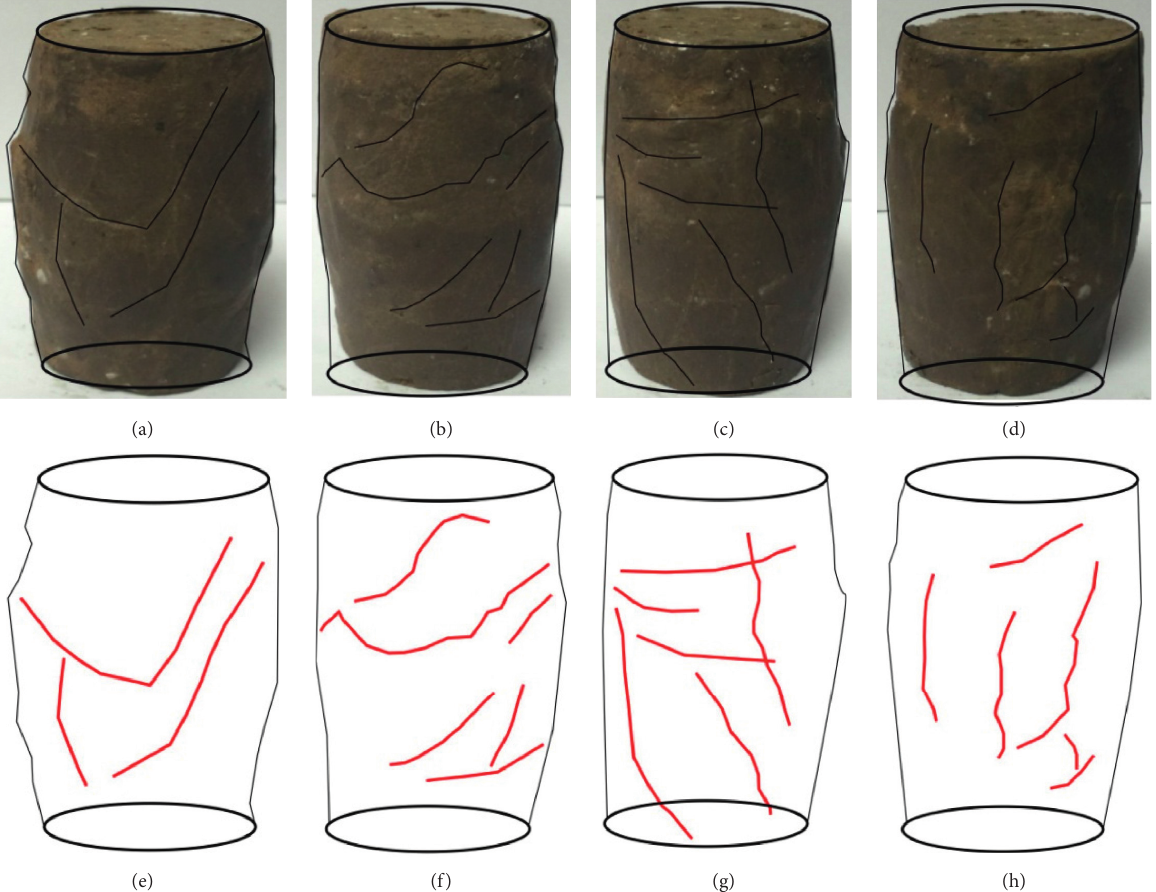
Figure 11: The failure morphology of the tested bimrock sample. (a) ∼ (d) Failure morphology, corresponding to the anterior, left, posterior, and right side of the sample. (e) ∼ (f) Crack sketch maps of the four